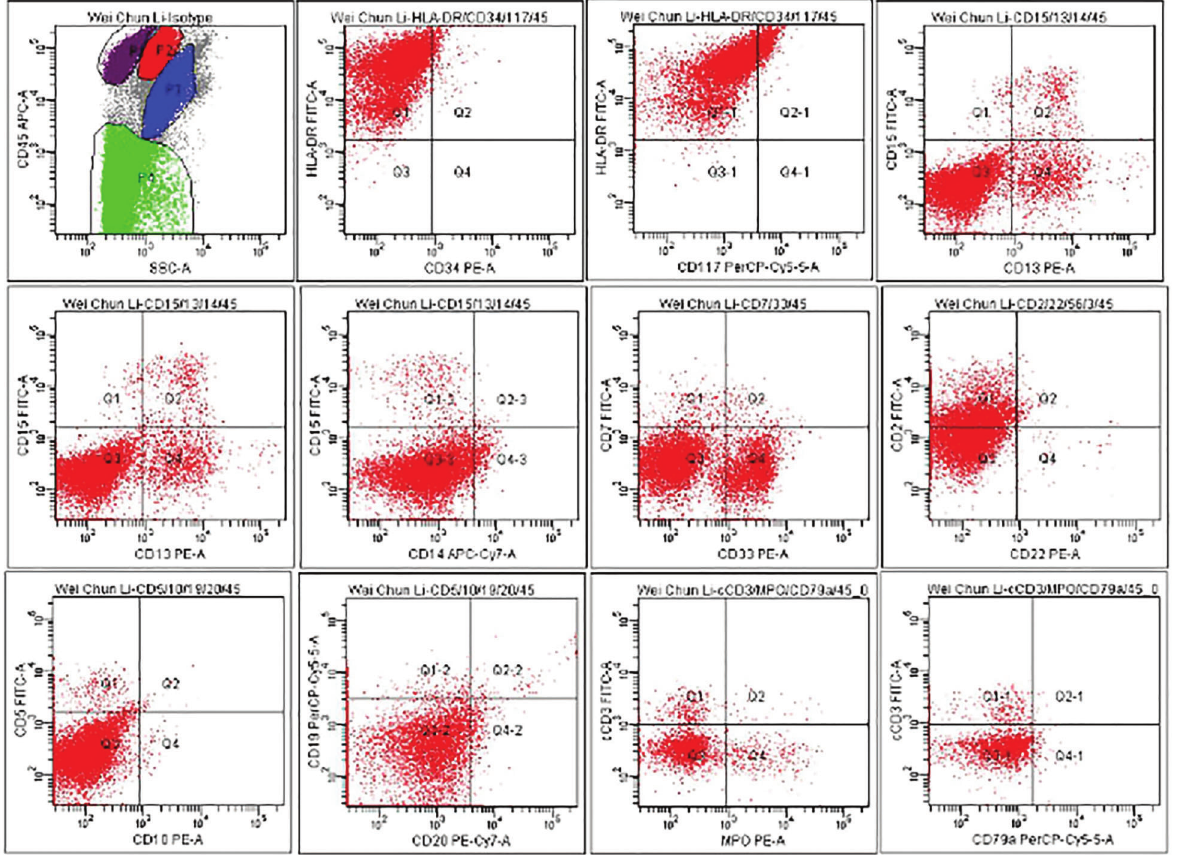
Figure 2. FCM-antigen results for HLA-DR=99.5%, CD13=13.5%, CD33=24.4%, CD2=37.8%.